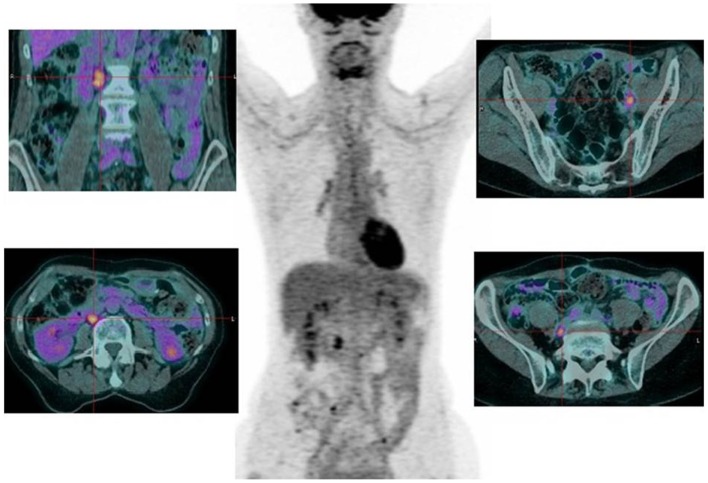
Seventy-two-year-old patient suspected of pelvic recurrence of ovarian cancer. The CT was negative and CA125 normal (12 U/mL for N < 35), but with increasing kinetic. PET/CT found nodal retroperitoneal and pelvic abnormalities.